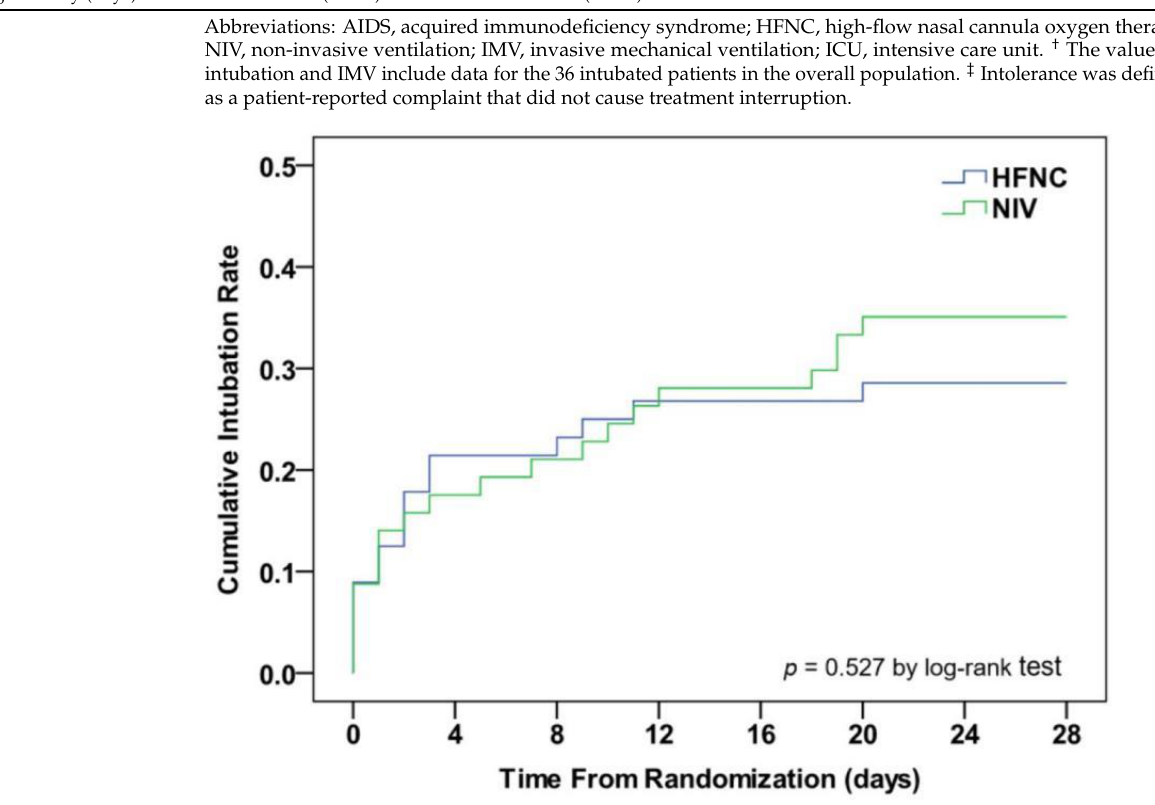
Figure 2. Kaplan–Meier curve analysis of cumulative intubation rate in AIDS patients with ARF. AIDS, acquired immunodeficiency syndrome; ARF, acute respiratory failure; HFNC, high-flow nasal cannula oxygen therapy; NIV, non-invasive ventilation.